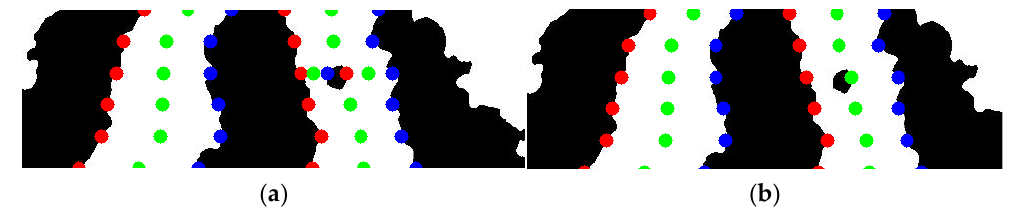
Figure 8. k- means clustering process; ( a ) before clustering; ( b ) after clustering.